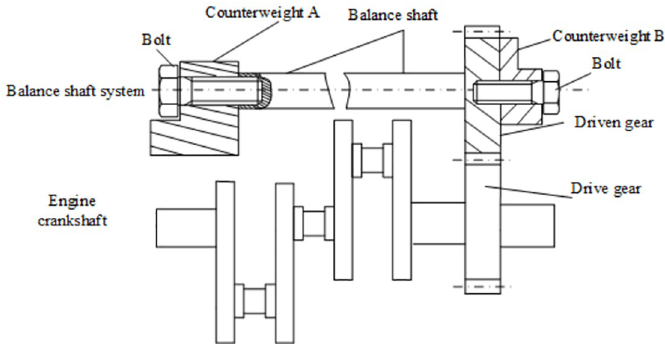
Fig 1. Schematic diagram of the balanced system structure in the three-cylinder